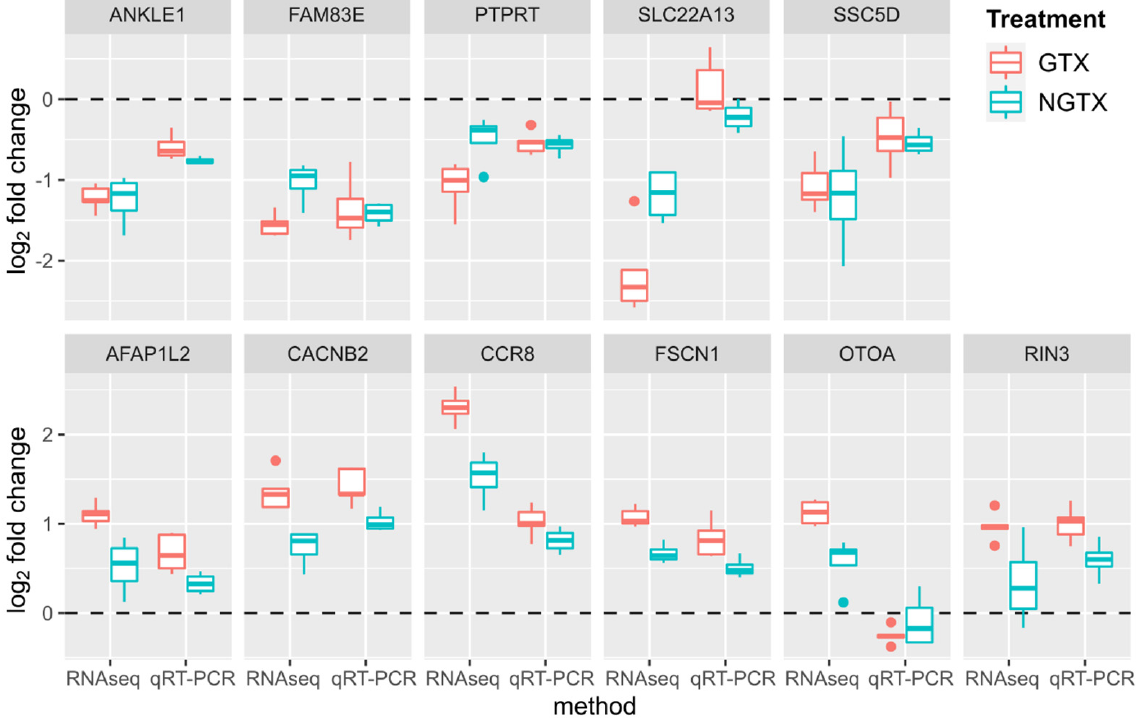
Figure 7. Expression changes of transcript markers in TK6 cells measured by RNA sequencing and quantitative reverse transcriptase polymerase chain reaction (qRT-PCR). Based on the PLS-DA to discriminate GTX from NGTX, 12 protein-coding genes were selected that were both significantly regulated by as many compounds as possible and listed as highly informative classifiers, i.e., among the top predictors of components 1 and 2 in the PLS-DA. Validation of the genes was performed by qRT-PCR compounds and was successful for all genes except for DNLZ. Here, the log 2 FC values are depicted for GTX (red) and NGTX (blue), the upper panel shows downregulated genes and the lower panel upregulated genes. Overall, the qRT-PCR data were in agreement with the RNA sequencing-derived log 2 FC values (Pearson correlation coefficient: 0.75, p -value: 5.24 × 10 − 19 ) and mostly confirmed the direction of